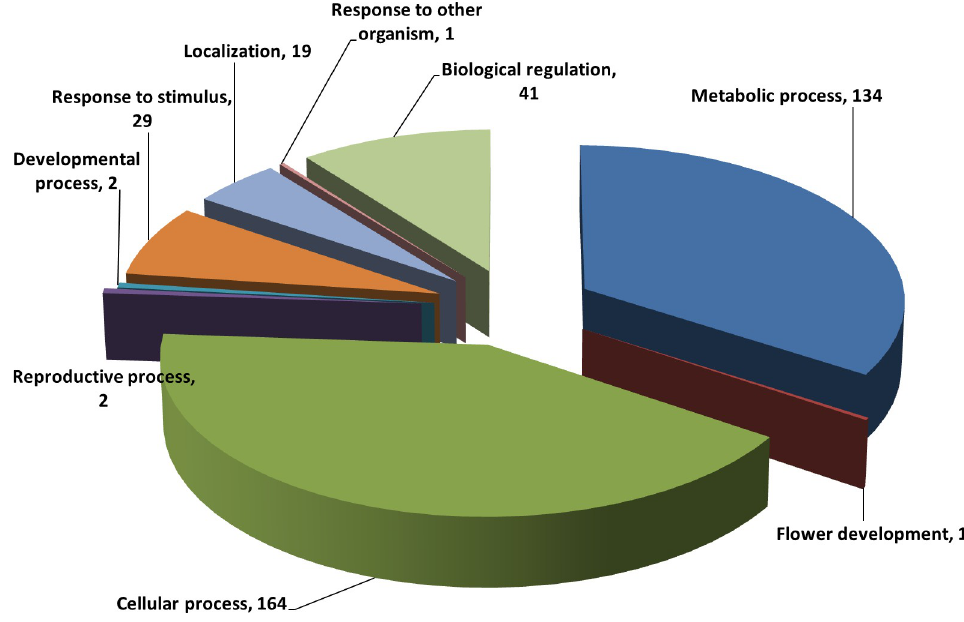
Fig 5. Gene ontology of 213 C . arietinum TE-gene chimeras assigned to 393 biological processes GO terms.